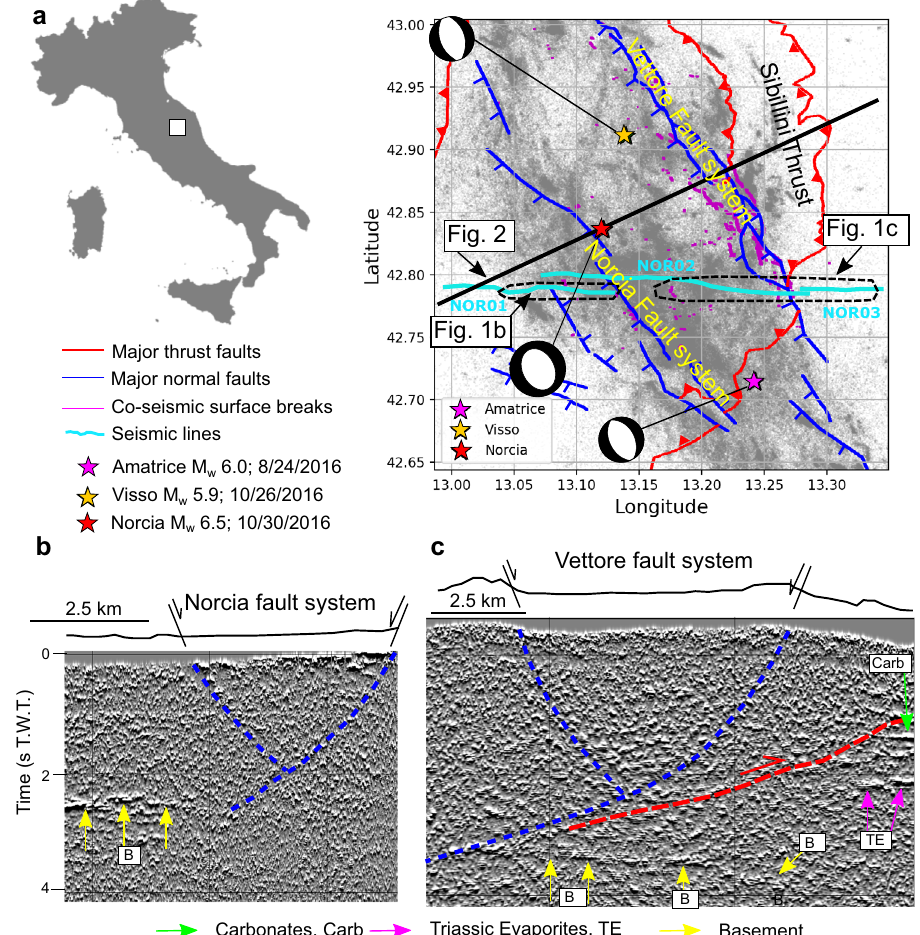
b , c seismic images of the subsurface geology (seismic traces are reported in a ). Blue dashed lines are the Norcia and Vettore fault systems at depth (details in Supplementary Note 1 and Supplementary Figs. 1,